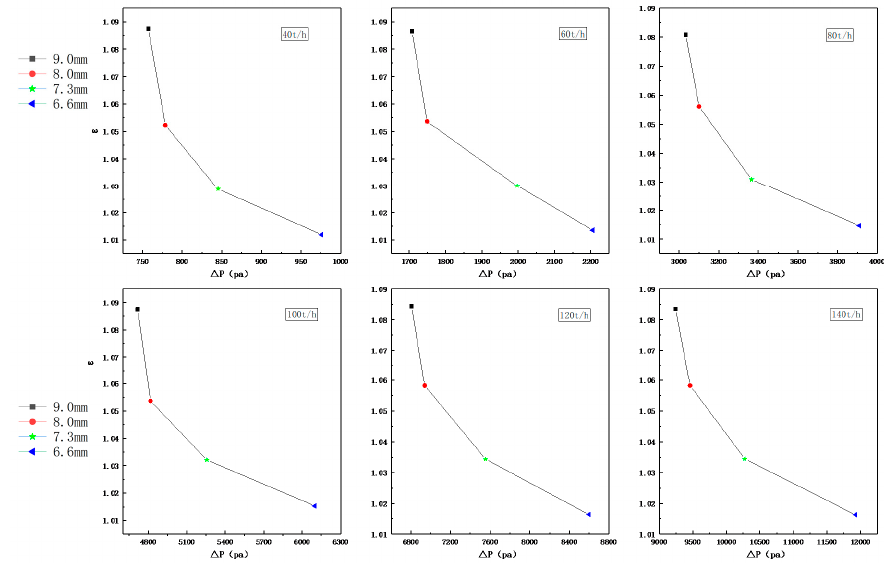
ffi cient vs. pressure loss at di ff erent flow Figure 12. Uniformity coefficient vs. pressure loss at different flow rate. Figure 12. Uniformity coe